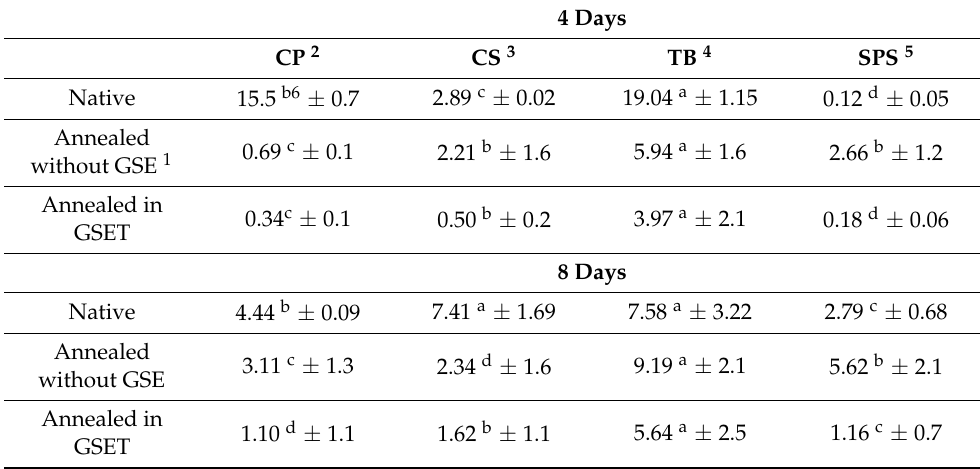
Table 7. The effect of enzyme extract (GSE) on the % syneresis of annealed starches at 60 ◦ C for 60 min after 4 and 8